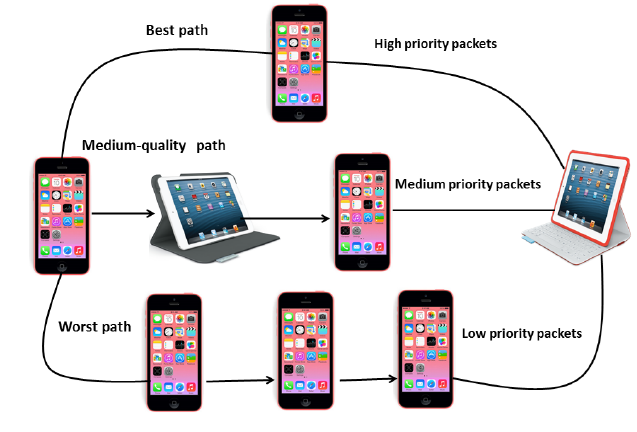
Figure 2. Multipath routing scheme using three